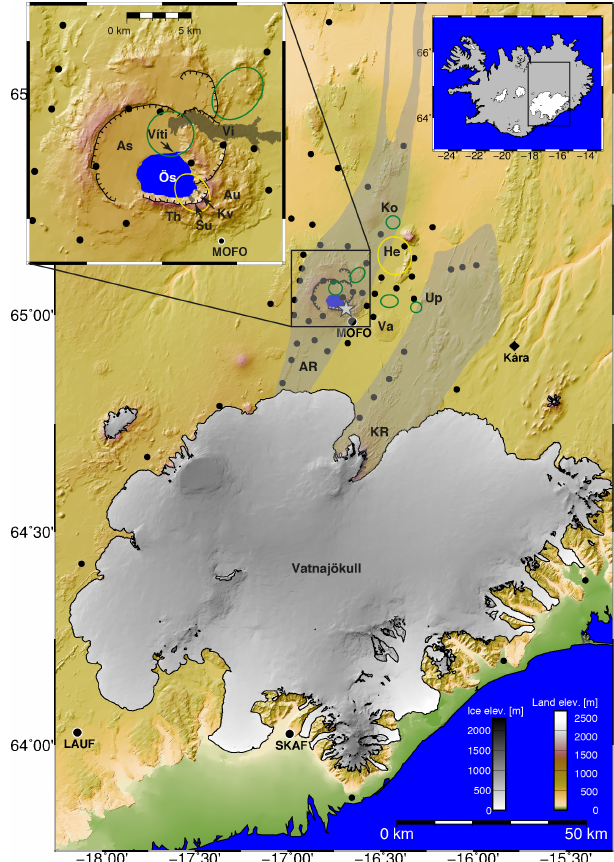
Figure 1. The Askja central volcano north of the Vatnajökull ice cap in the Icelandic highlands with locations of the seismic stations (black circles). The white star is the source location of the 21 July 2014 landslide. The Kárahnjúkar weather station (Kára) is indicated with a black diamond. Inset of the Askja central volcano shows the hyaloclastite mountains of Austurfjöll (Au) and Thorvaldsf- jall (Th), the caldera ring faults of the Askja caldera (As) and the Öskjuvatn caldera (Ös), the small explosion crater Víti, the basaltic 1922/23 eruption sites of Suðurbotnahraun (Su) and Kvíslahraun (Kv), and the 1961 Vikrahraun (Vi) lava flow (grey shading). The areas of deep crustal earthquakes at the Kollóttadyngja (Ko) shield volcano, at the hyaloclastite Upptyppingar mountain (Up), north of the Vaðalda shield volcano (Va), and at the Askja caldera north side are indicated with green ellipses. Areas of shallow crustal seismic- ity at the Herðubreið table mountain (He), and at the south-eastern edge of the Öskjuvatn caldera are shown with yellow ellipses. The Askja (AR) and the Kverfjöll rift (KR) segments are shaded in light grey (Einarsson and Sæmundsson,